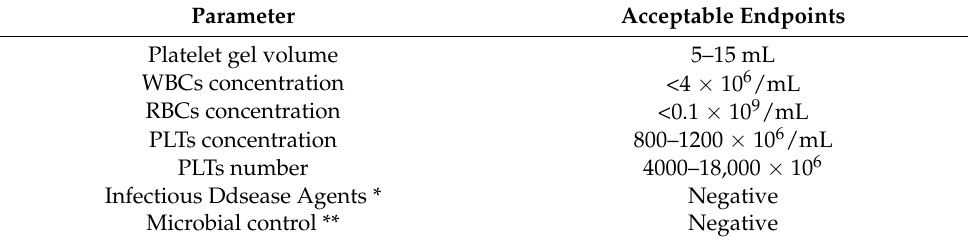
Table 2. Acceptance criteria of